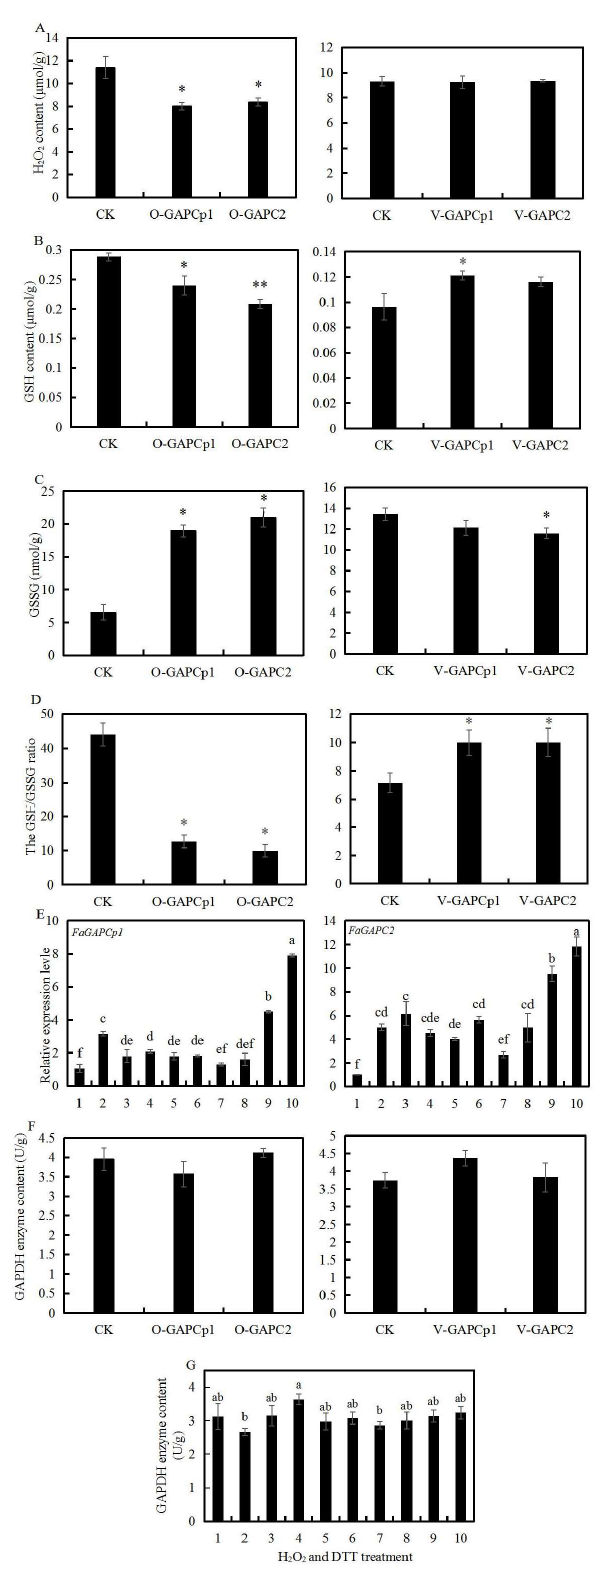
Figure 6. The interplay between FaGAPC2 and FaGAPCp1 functions and oxidative stress. ( A ) The H 2 O 2 content in the control and transient FaGAPC2 and FaGAPCp1 expressing fruits; ( B ) the reduced glutathione (GSH) content in the control and transient FaGAPC2 and FaGAPCp1 expressing